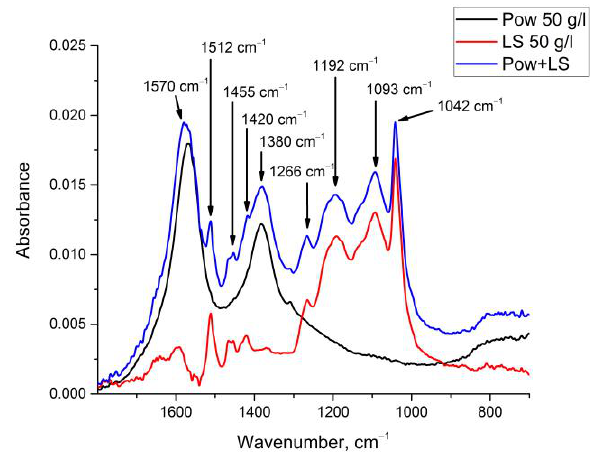
Figure 4. ATR absorption spectra of centrifuged aqueous solutions of sodium lignosulfonate, potassium humate Powhumus (Pow), and their 1:1 mixture, with concentrations of 50 g/L.